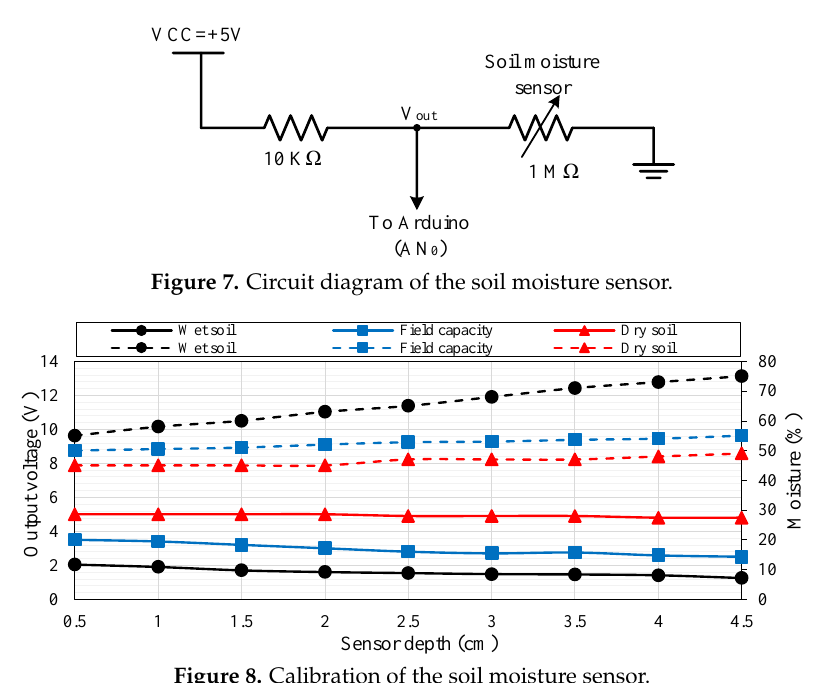
Figure 8. Calibration of the soil moisture sensor.